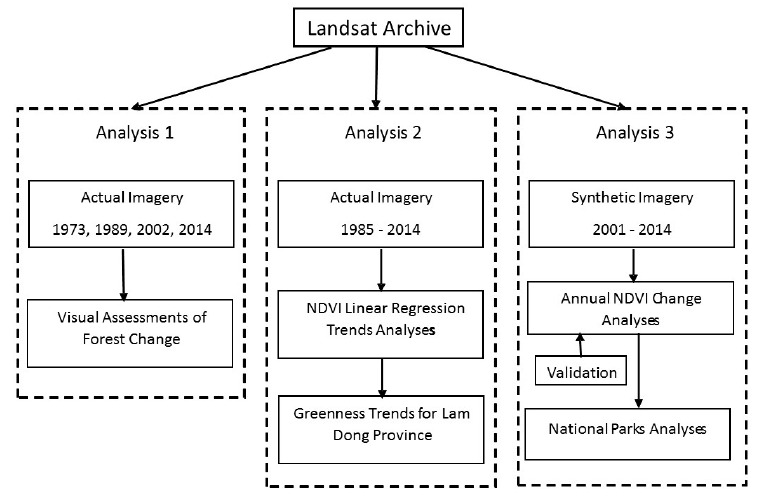
Figure 4. Flow chart summarizing the major steps taken during the investigation. NDVI: Normalized Difference Vegetation Index.